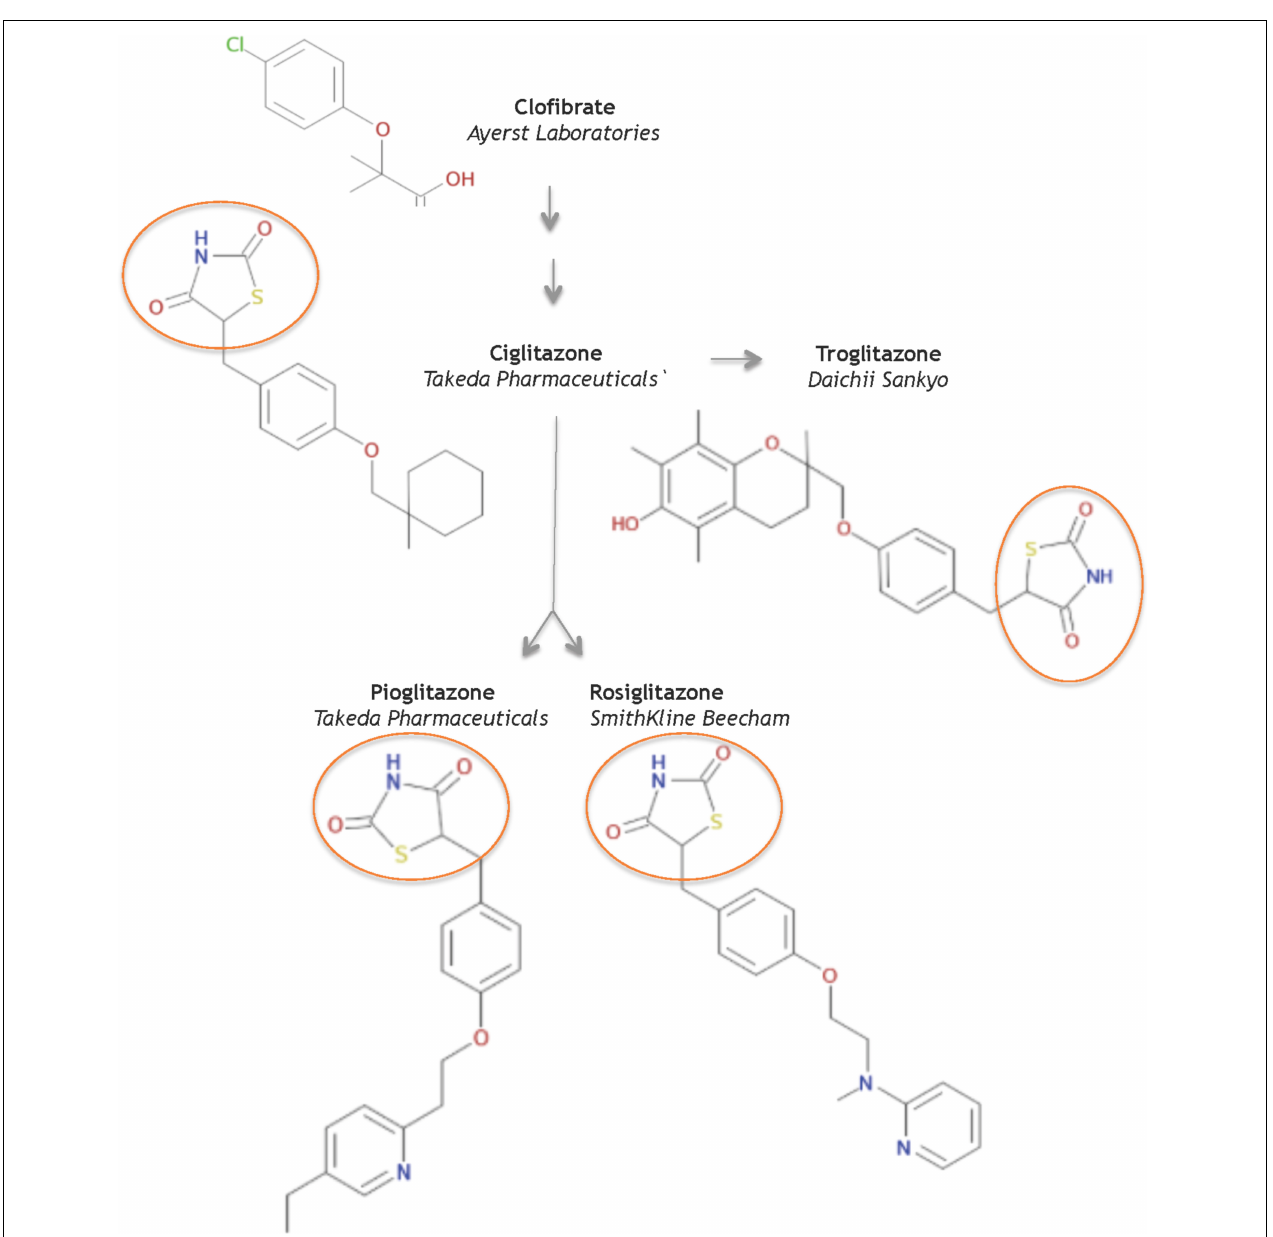
FIGURE 1 | Structures of key compounds in pioglitazone discovery (Gaulton et al., 2012; Bento et al., 2014).